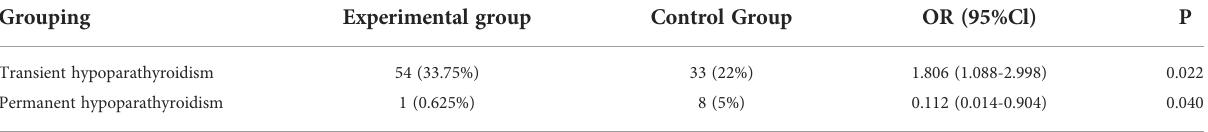
TABLE 2 Parathyroid autotransplantation and risk of hypoparathyroidism.